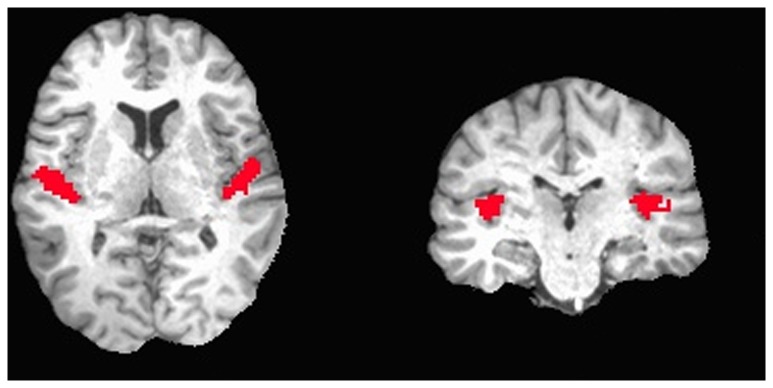
A representative subject illustrating voxels selected using an anatomically defined ROI.